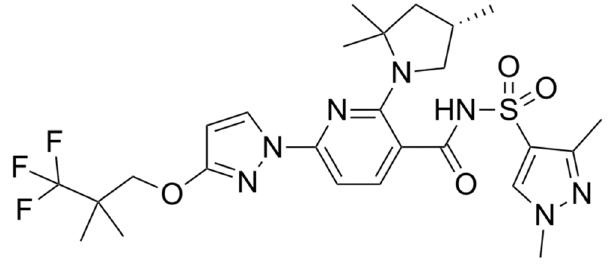
Figure 6. Chemical structure of Elexacaftor.